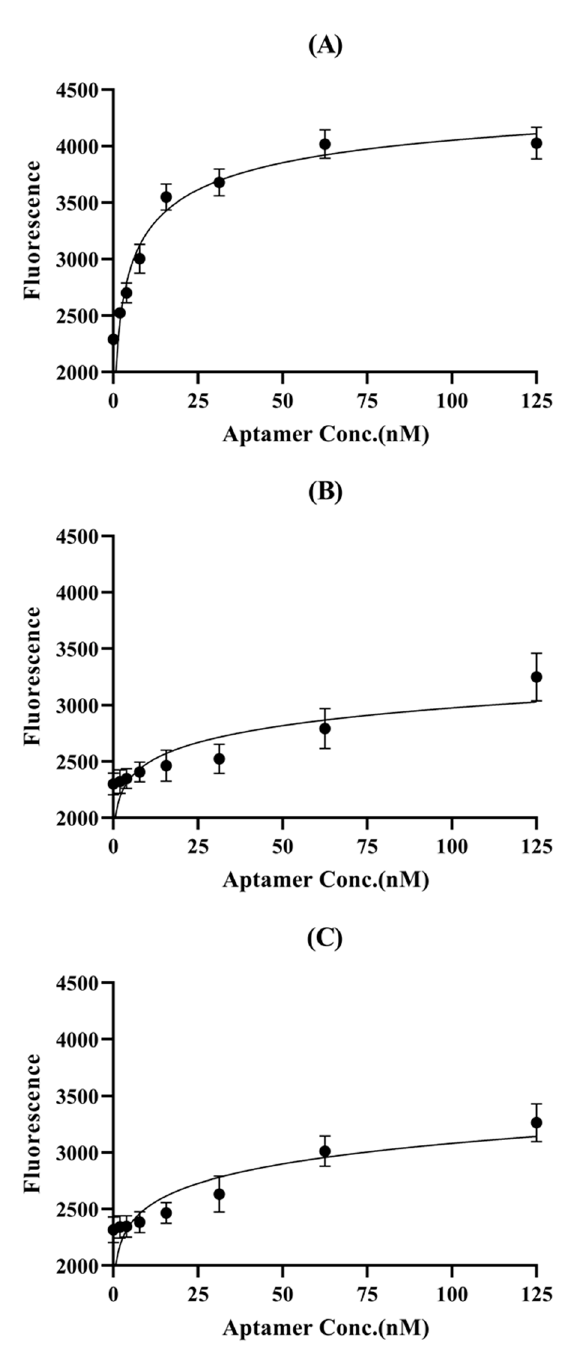
Figure 2. Binding affinity test of aptamer candidates with fluorescence signals. The K d value of ( A ) GABAS-01 is 1.748 ± 0.227 nM, ( B ) GABAS-02 and ( C ) GABAS-03 were not determined.